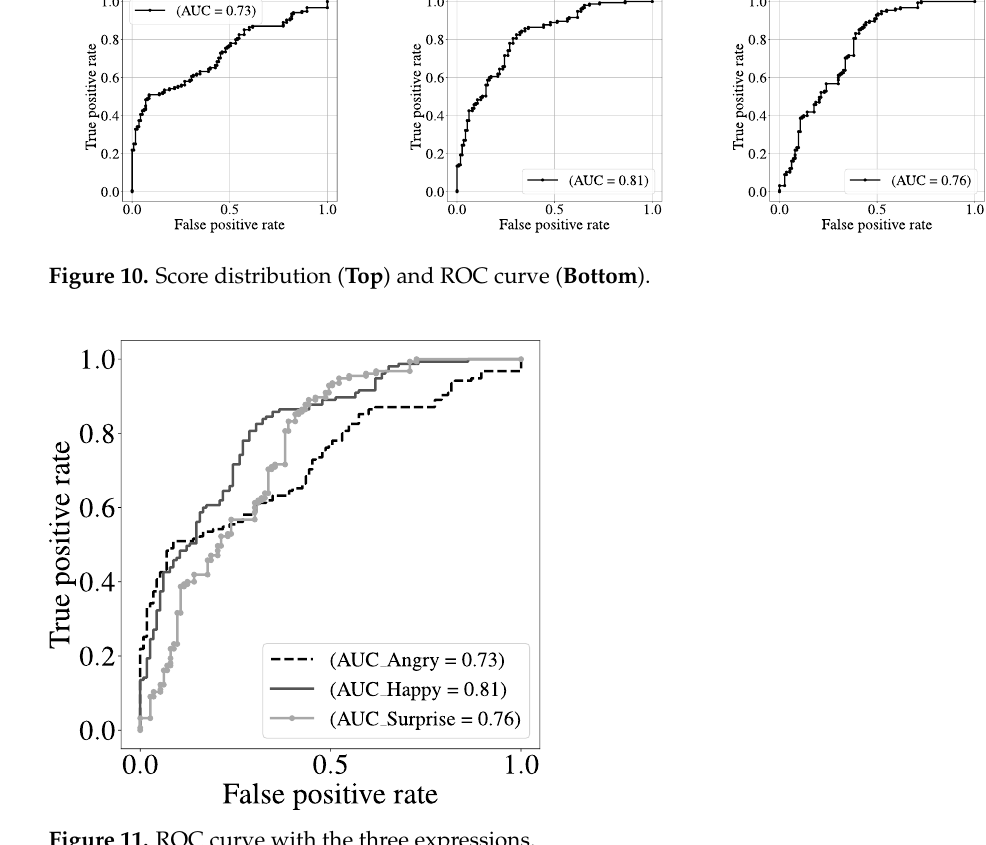
Figure 11. ROC curve with the three expressions. Table 2. PD classification results and optimal parameters analyzing angry expression.